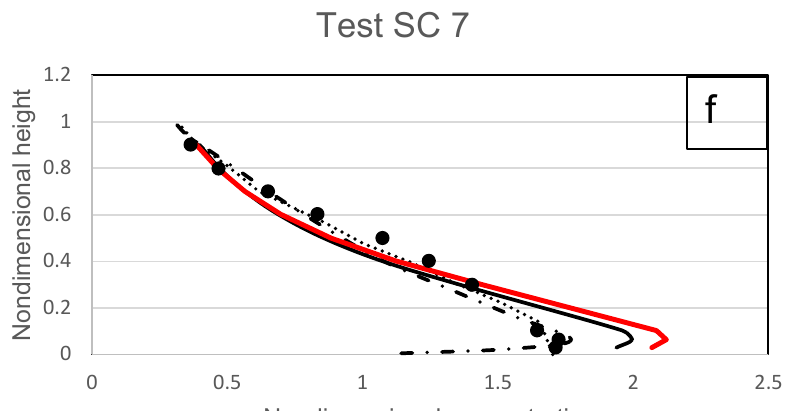
Figure 18. ( a – f ) Modelled results and comparisons against experimental data of Wang and Qian [37] The accuracy of the various models, including the suggested model, decreases at the lower-suspension region, according to an overview of all the results shown in Figure 18. Compared to type III profiles, type II profiles have higher concentrations and a smaller turning point near the bed. Rather than suspended load, bedload behaviour governs the distribution of sediment along the wall boundary. In Wang and Qian ’ s [37] investigation, plastic particles were also utilised in the flow, and theoretically, under the influence of particle – particle interacting forces, it produced less notable movement than the normal and natural sediment. This means that, in contrast to models by Ni et al. [10] and Zhong et al. [23], which incorporated empirical functions discovered from the relevant experiments into the modelling, the proposed model, which deals with the forces by coupling expressions of Rouse and size parameters, is unable to simulate its near-bed concentration reasonably for experiments SF2, SC5, and SC6 as shown in Figure 18a, Figure 18e, and Figure 18f respectively. Results of the proposed model are better than those from Pu et al. [1] for experiments SF5, SM6, and SM7 as shown in Figure 18b, Figure 18c, and Figure 18e. 4.3. Michalik Michalik [36] researched the sediment profile of hyper-concentrated flows using experimental data. Sand with a diameter of 0.45 mm and concentrations ranging from 0.15 to 0.54 was employed as the sediment material (all the tested conditions are shown in Table 5). The linear law found in Equation (20) is used in this study to model Michalik ’ s tests. The test findings are displayed in Figure 19a – h, where measurements and the proposed model results are contrasted. Table 5. Data by Michalik [36]. Test No.